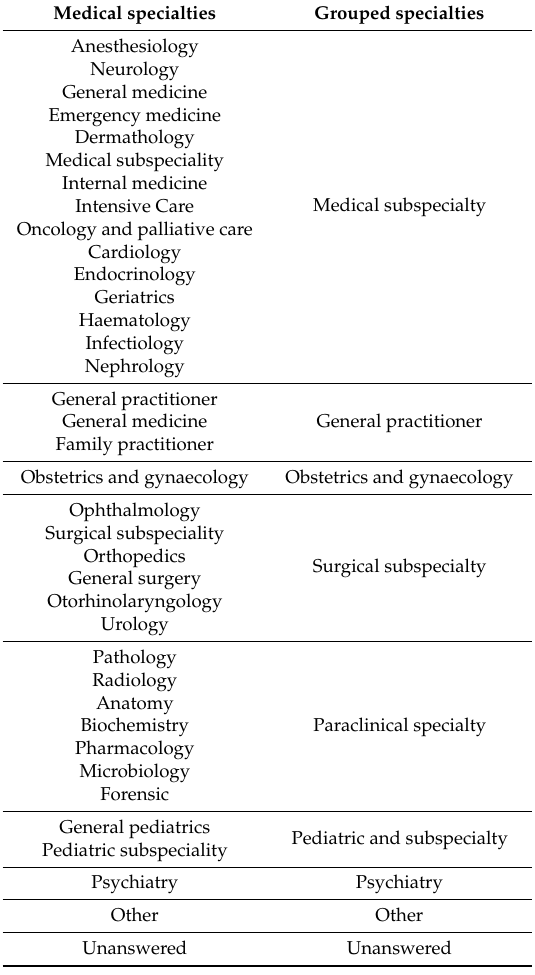
Table 2. Included options for ’Medical specialties’, and aggregation used for